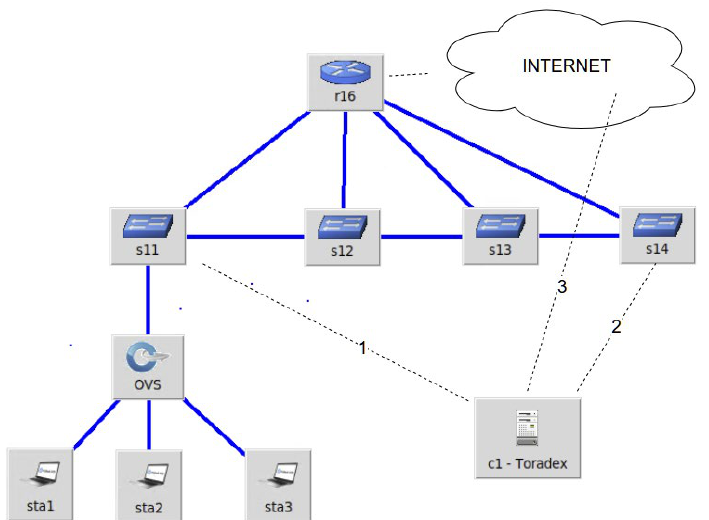
Figure 5. Design for the portability network topology using a Toradex i.MX6 board as an SDN con- troller.